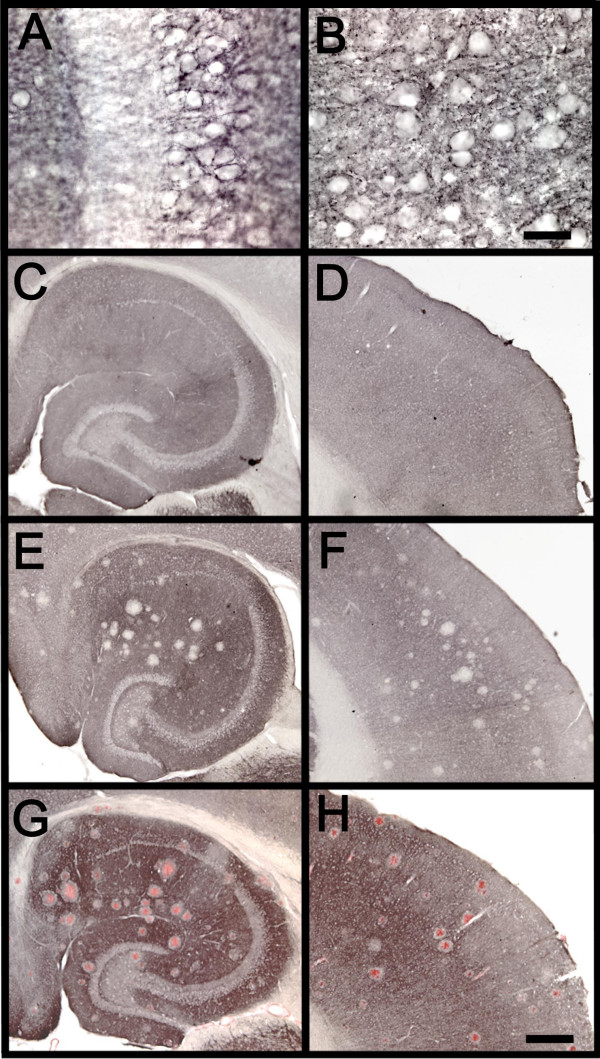
Hippocampal and cortical immunohistochemistry for Na+/K+ ATPase in APP+PS1 mice and non-transgenic littermates. Horizontal hippocampal and cortical sections were immunostained for Na+/K+ ATPase αII. The left panels depict hippocampus, while the right panels encompass the cerebral cortex. Panels A & B: high power magnification (Scale bar = 8.33 μm) revealed membrane-localized staining for Na+/K+ ATPase in the insular cortex (Panel B) and CA3 of the hippocampus (Panel A) of non-transgenic mice. Panel C: hippocampal staining of non-transgenic mice showed a ubiquitous distribution of Na+/K+ ATPase throughout the neuropil, while less staining was apparent along the pyramidal layer of Ammon's horn, the hilus and the granular layer of the dentate gyrus. Panel D: cortical staining was also substantial with slight lightening in layers 1 and 2. White matter in both structures remained unstained. A similar staining pattern was observed in the APP+PS1 mice with the exception of focal non-stained areas in the gray matter, presumably where amyloid plaques are located (Panel E [hippocampus] & F [cortex]). Immunostaining followed by Congo red histochemistry confirmed that the Na+/K+ ATPase staining was absent not only immediately where amyloid was located, but also in a zone surrounding the plaque (Panels G [hippocampus] & H [cortex]). Scale bar for panels C-H = 120 μm.